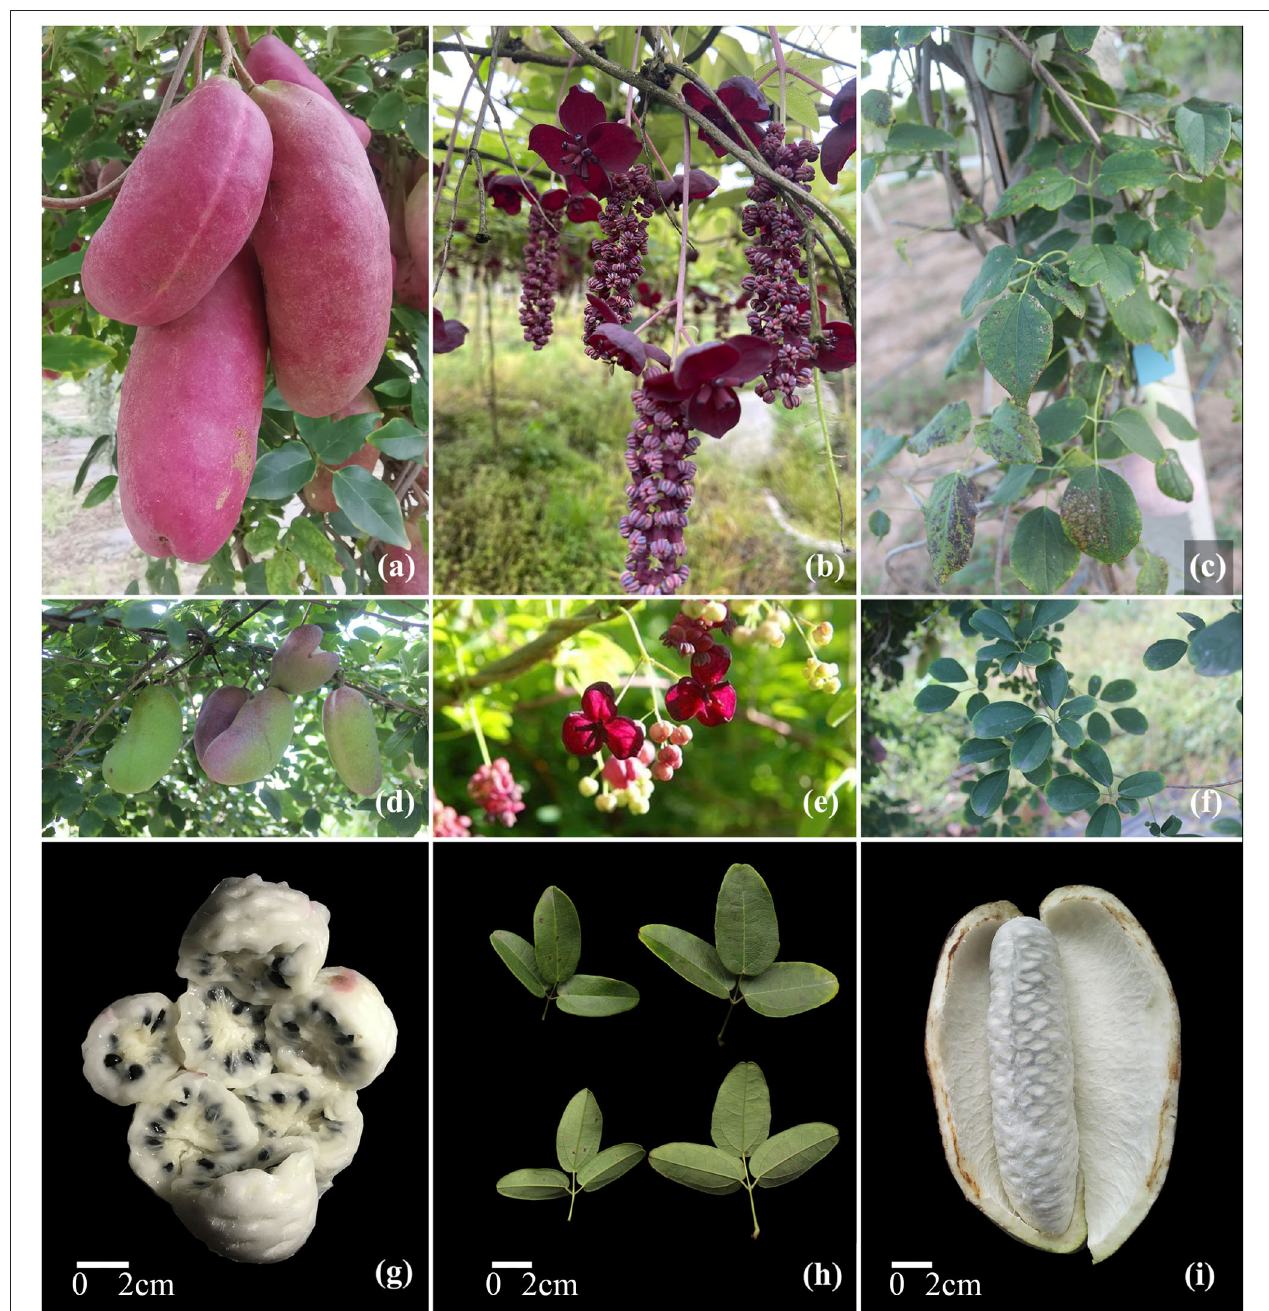
FIGURE 1 | Akebia trifoliata and A. quinata . (a–c) fruit, flower, and leaves of A. trifoliata ; (d–f) fruit, flower, and leaves of A. qui nata. (g–i) flesh, leaflet, and cracking fruit of A. trifoliata .